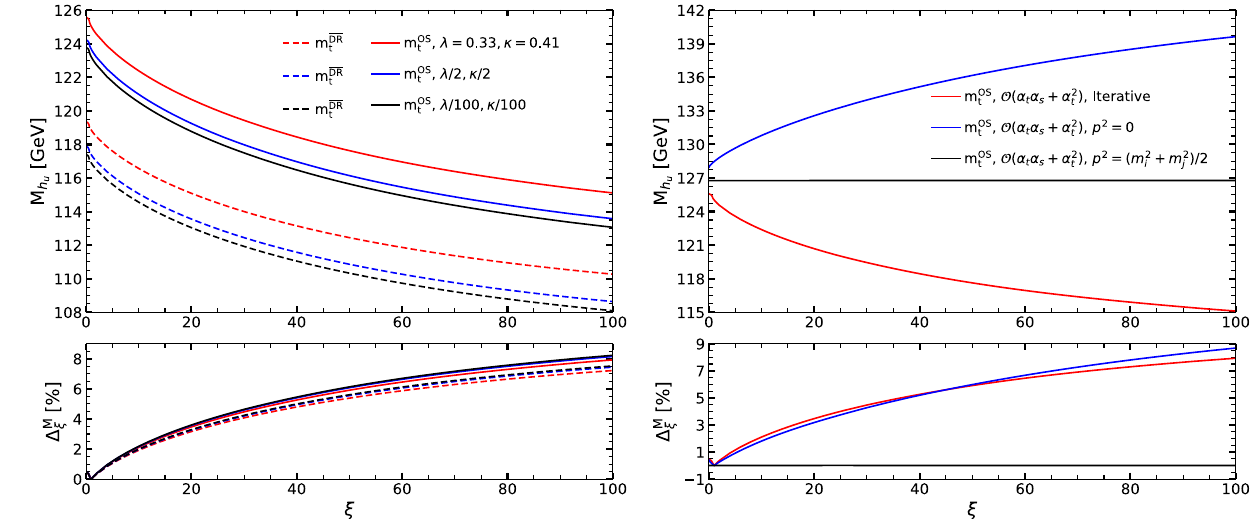
Right: The h u -like Higgs boson mass of scenario P2 as a function of ξ by applying iterative (red), the R 0 (blue) and the R mtree -method (black). Lower panels: The corresponding (cid:15) M ξ values in percent, as a function of ξ